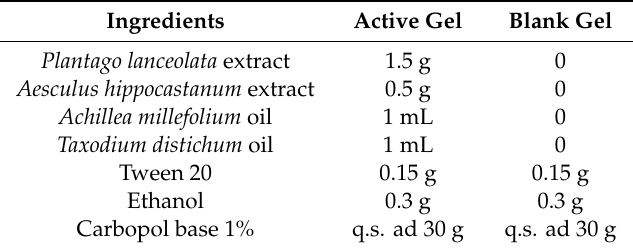
Table 1. Composition of prepared